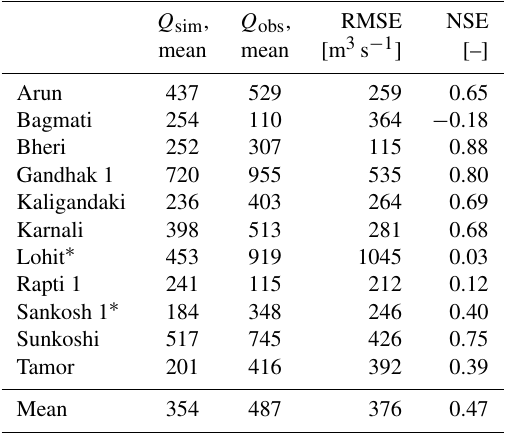
Table 4. Performance criteria for simulated discharge in the calibra- tion subcatchments 2002–2007.